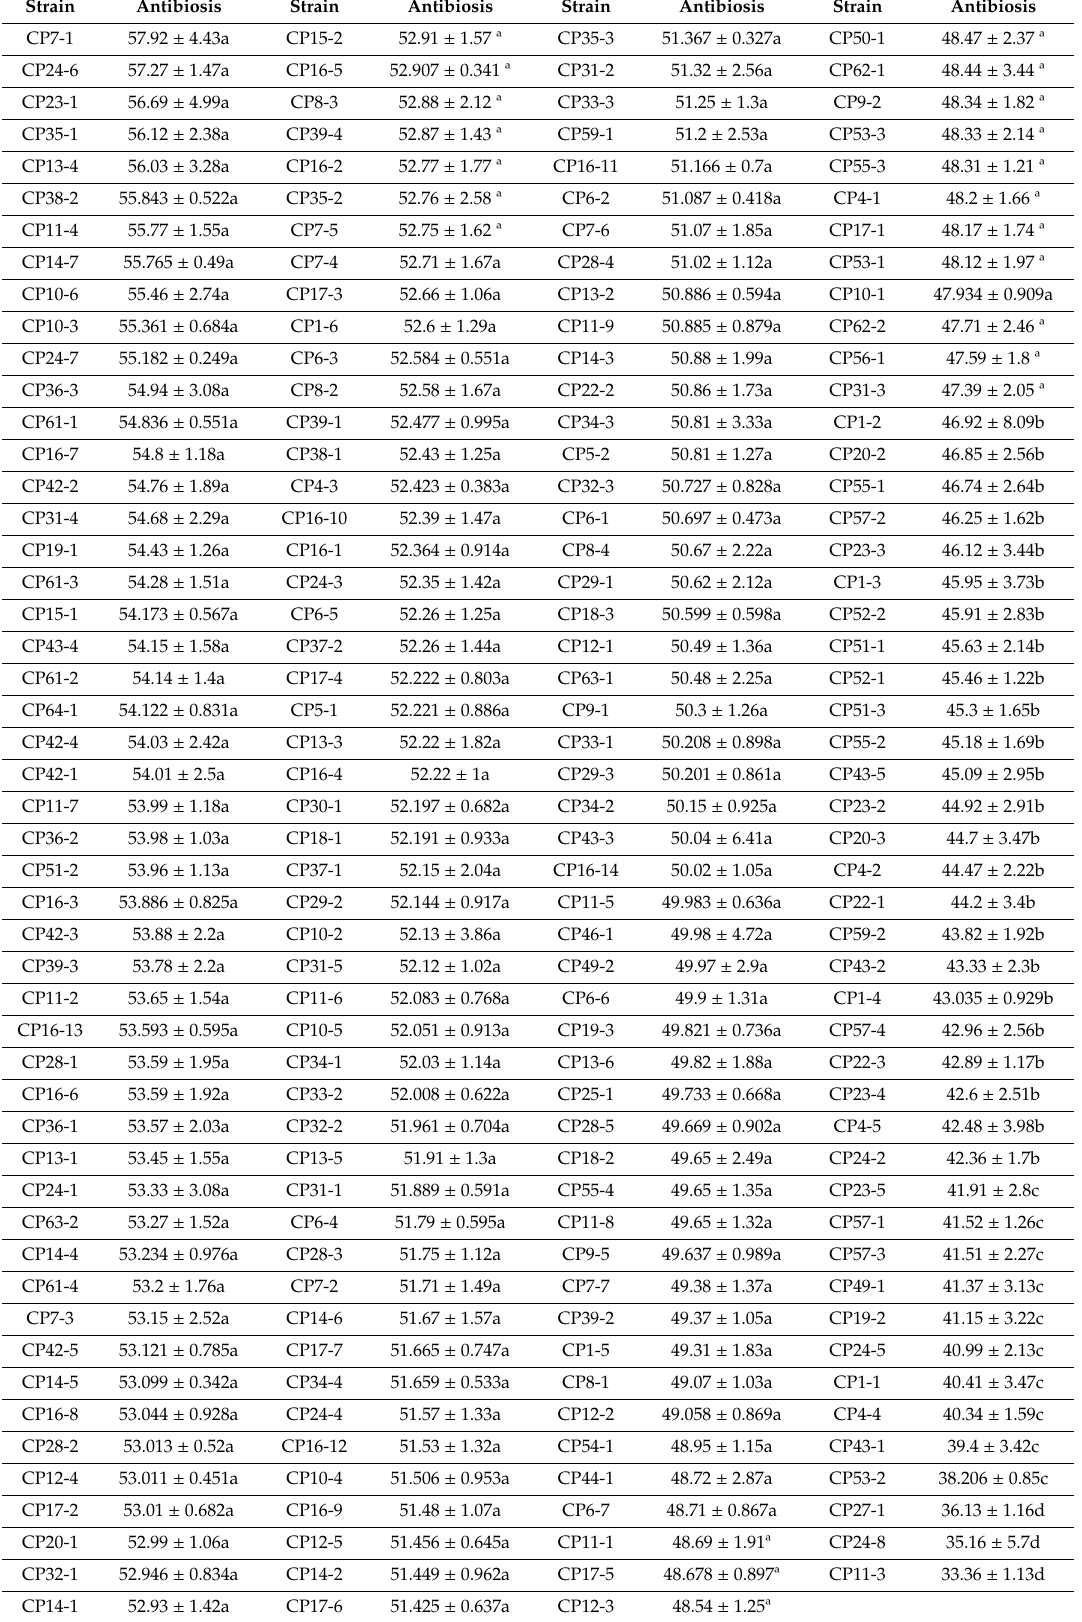
Table 3. Antibiosis of 199 native strains of Trichoderma from Bagua Province, Amazonas, Peru, evaluated over Moniliophthora roreri ( ± = standard error; average with the same letters are not statistically di ff erent (Scott Knott, α =